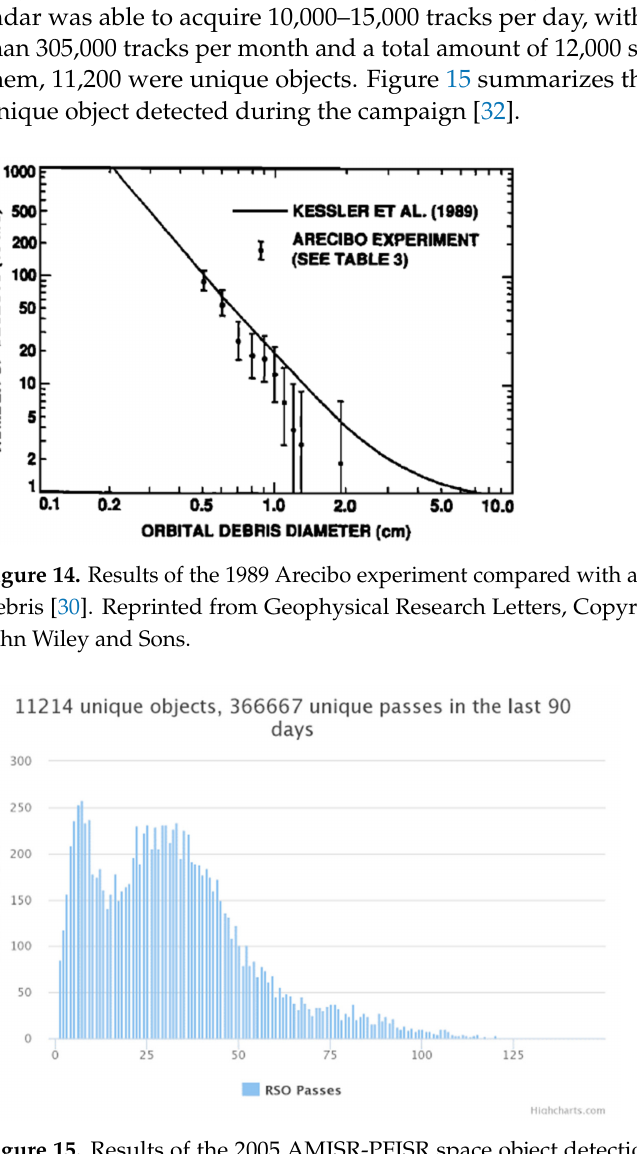
Figure 15. Results of the 2005 AMISR-PFISR space object detection experiment [32]. Reproduced with permission from Michael Nichols of SRI International and from the 2015 Advanced Maui Optical and Space Surveillance Technologies Conference (AMOS), Maui,